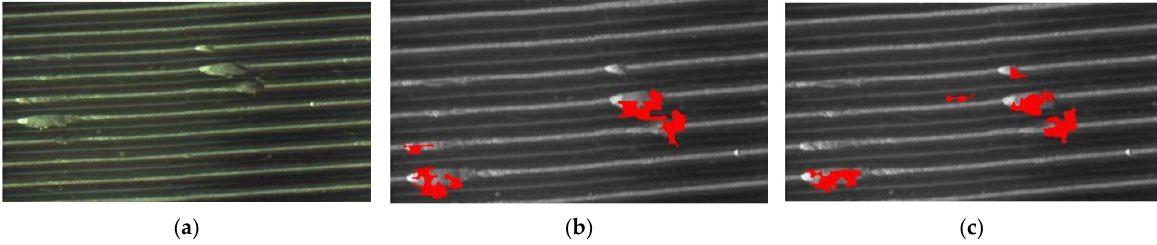
Figure 13. The patch images synthesized to the original panoramic image of CAE and AAE networks (unit: 0.03 mm/pixel). ( a ) Original synthesized image; ( b ) CAE synthesized image; ( c ) AAE synthesized image.